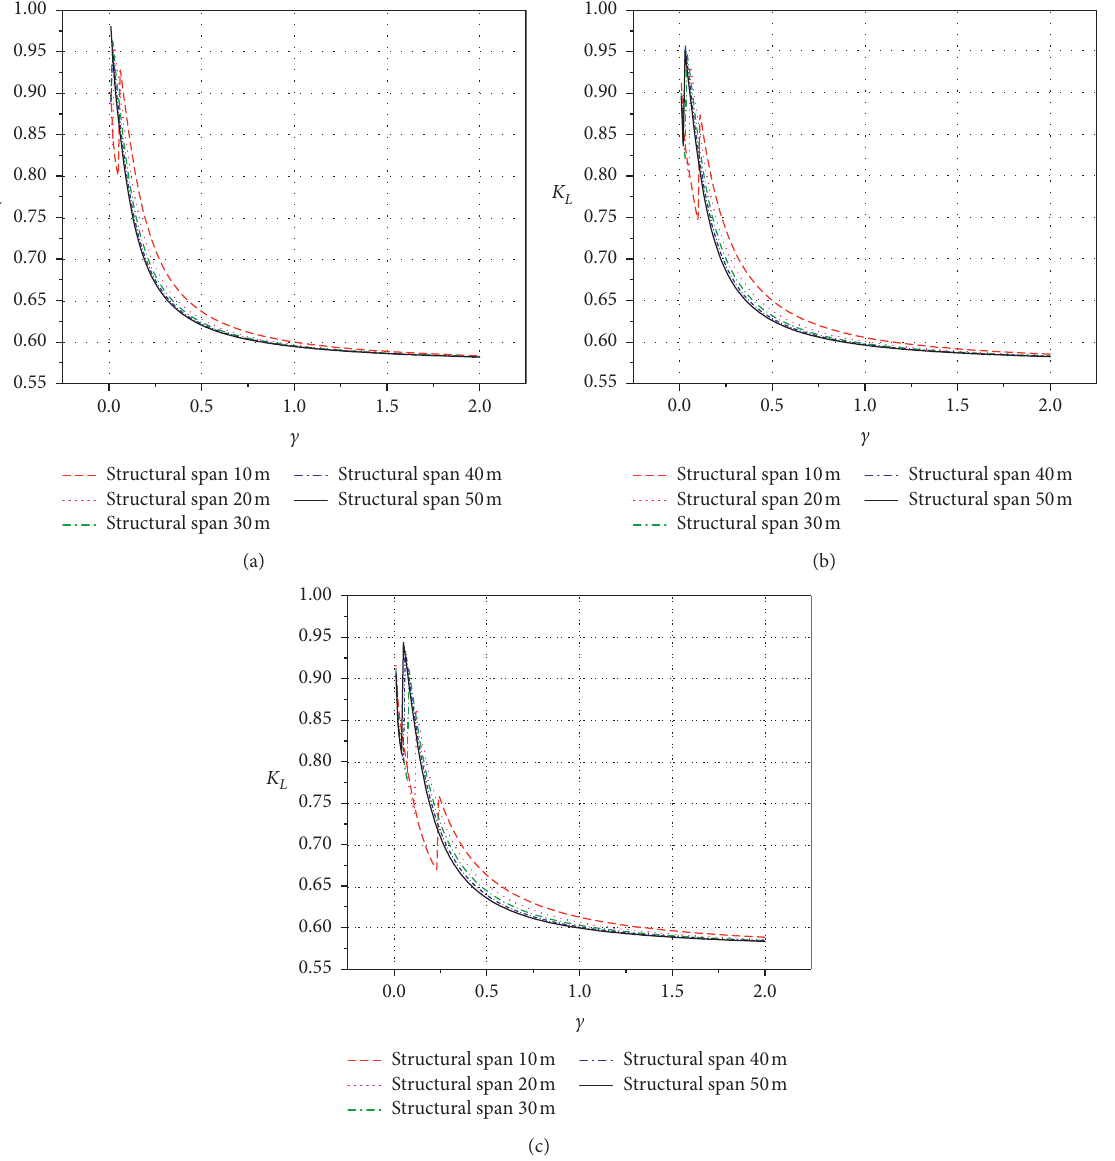
Figure 9: Equivalent load transformation factors of simply-fixed one-way members using Baker’s formula parameters: (a) W � 1 kg. (b) W � 10kg. (c) W �